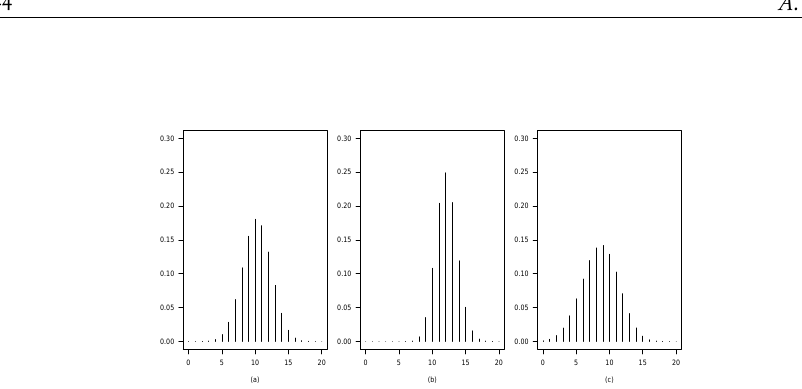
( θ ) } , in panel (a), where M = 350, m = 20, i ( θ , α ) } , for M = 350, m = 20, θ = 0.51, i